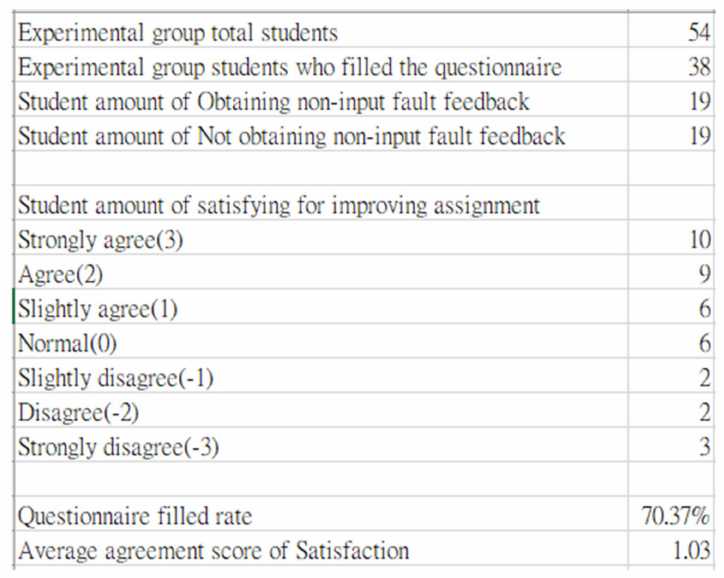
Figure 41. Student questionnaire survey